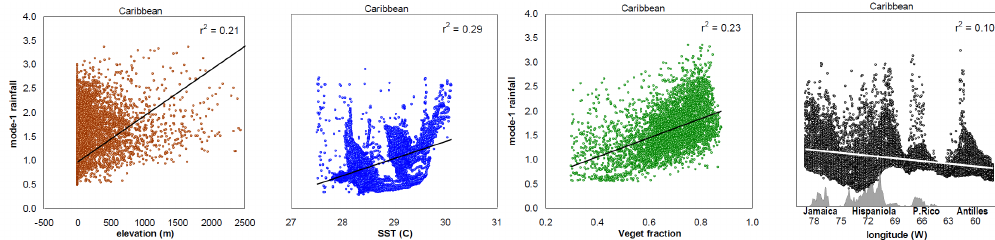
Figure A2. Spatial scatterplots of field-to-field rainfall (cf. Figure 3a) and (left-to-right): elevation (Figure 1a), SST (Figure 2c), vegetation (Figure 8a), and longitude, with topographic profile lower, and linear regression. At 5 km resolu-tion, the Caribbean field matrix is 59360 with 7182 pixels above sea level (e.g., land).